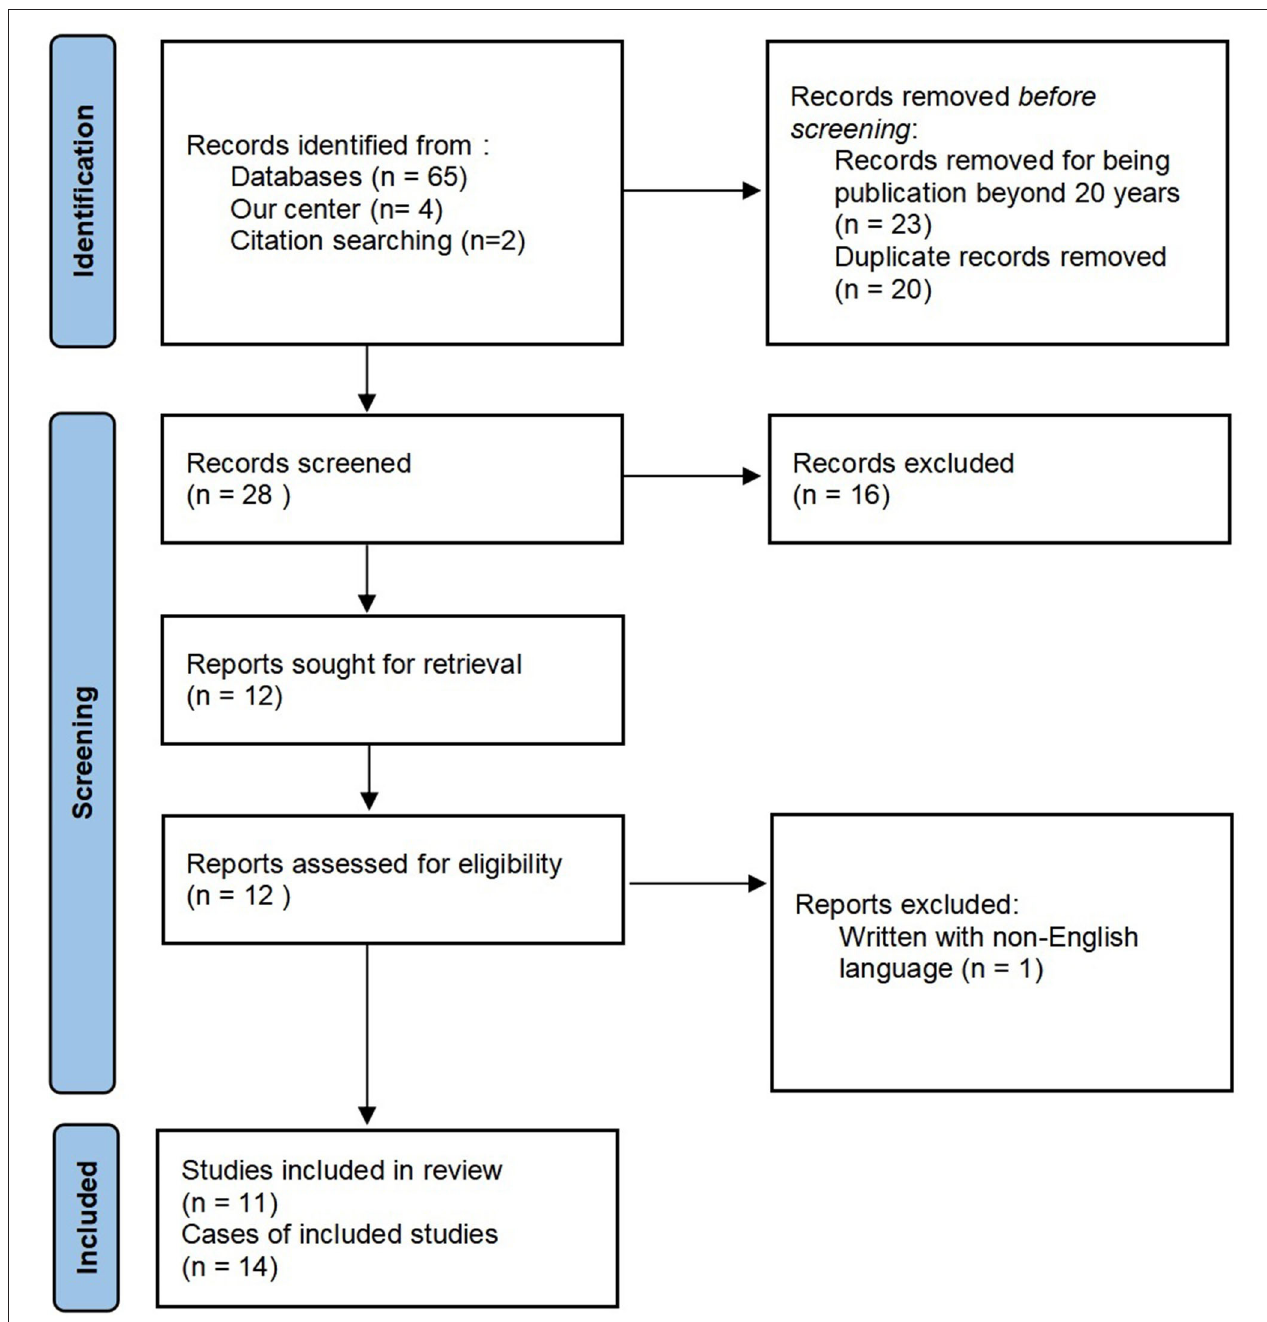
FIGURE 1 | Adopted PRISMA 2020 flow